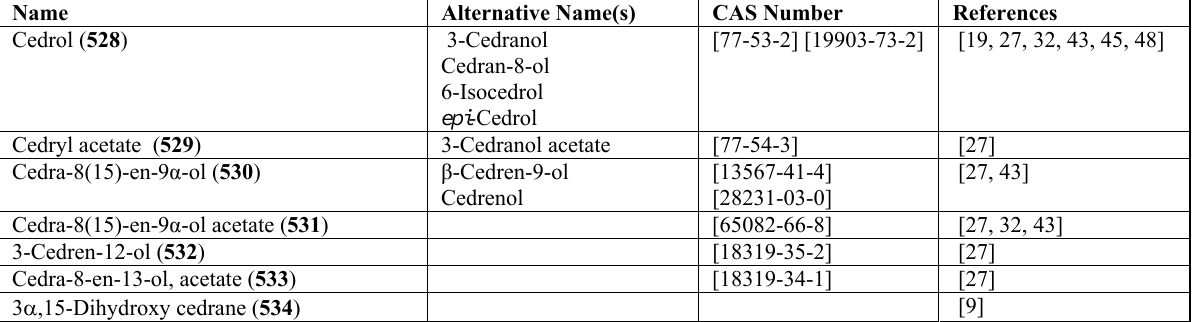
Table 41. Cedrane Sesquiterpenoids (Octahydro-3,6,8,8-tetramethyl- 1H -3 α